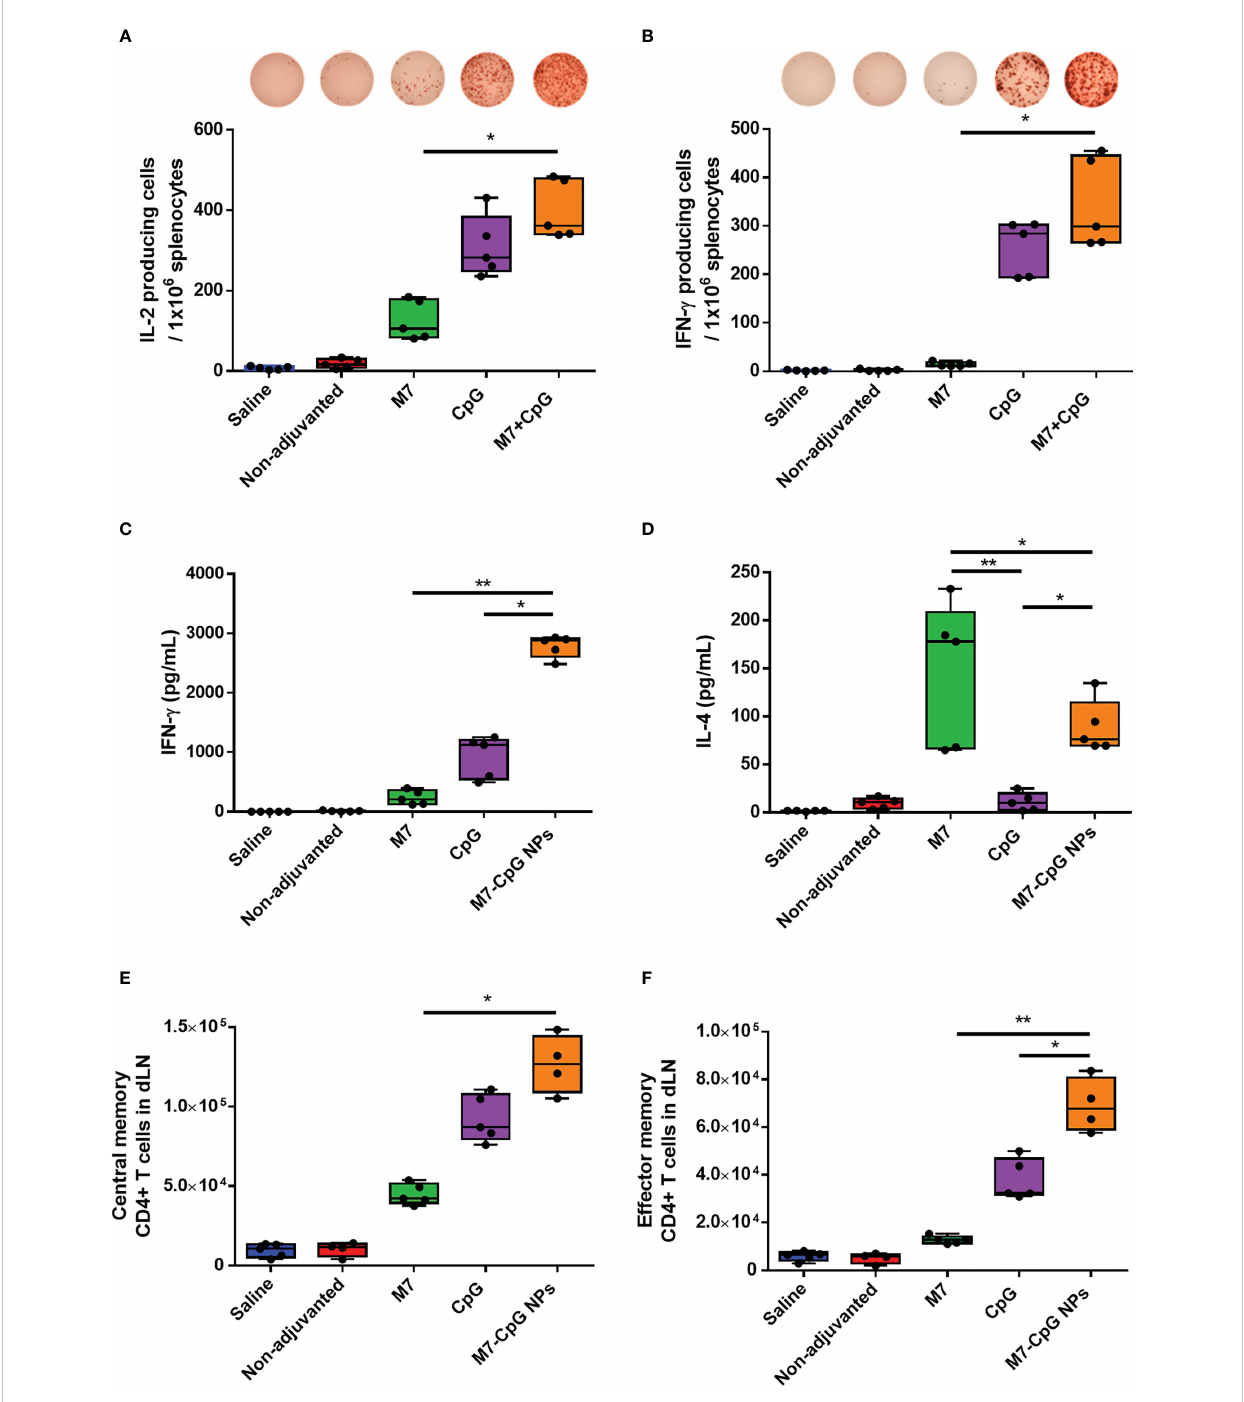
FIGURE 5 M7-CpG NPs potentiate and polarize the T-cell response against the COBRA in fl uenza antigen J4. C57BL/6 mice were intranasally immunized with saline, non-adjuvanted J4, M7 + J4, CpG + J4, or M7-CpG NPs + J4 as previously described. Spleens and draining lymph nodes (dLNs) were harvested on day 42 post-immunization. ELISPOT counts for (A) IL-2 and (B) IFN- g from antigen-recalled splenocytes. (C) IFN- g and (D) IL-4 release was evaluated in supernatants from antigen-recalled splenocytes. Total number of (E) central memory and (F) effector memory CD4+ T cells in dLN. Data are presented as mean ± range ( n = 5) (representative plots of two independent experiments). Signi fi cant differences were determined using a one-way ANOVA test with Tukey ’ s multiple comparison on the data shown (* p ≤ 0.05; ** p ≤